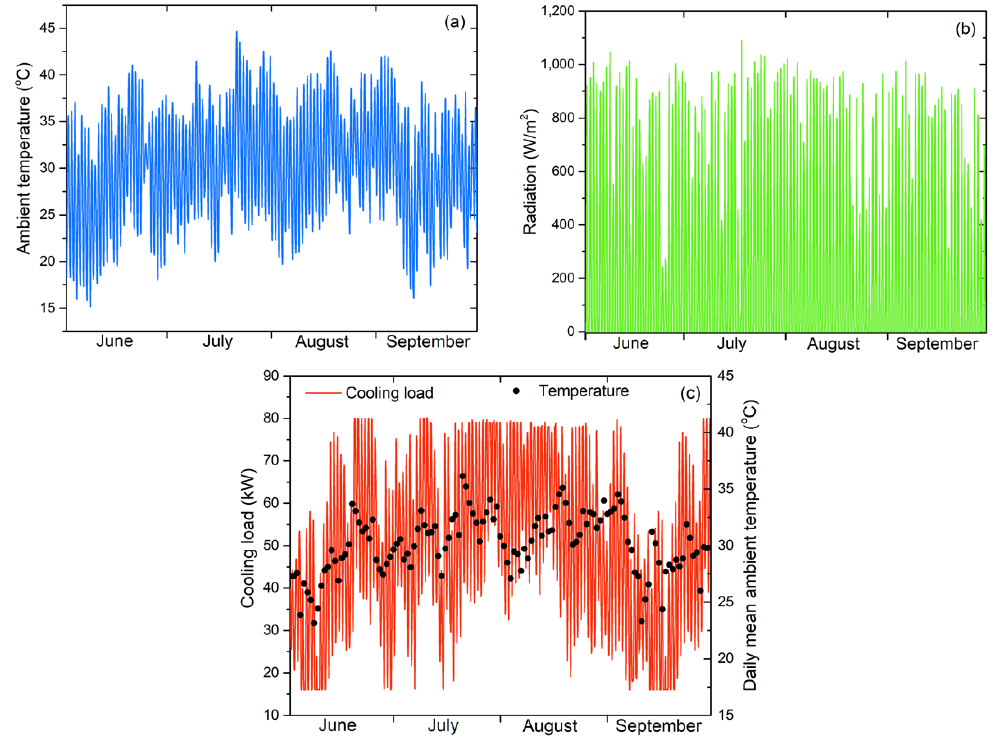
Figure 3. Profile of ( a ) ambient temperature, ( b ) global radiation, and ( c ) cooling demand and daily mean ambient temperature used in the simulation of the solar cooling and desalination system.